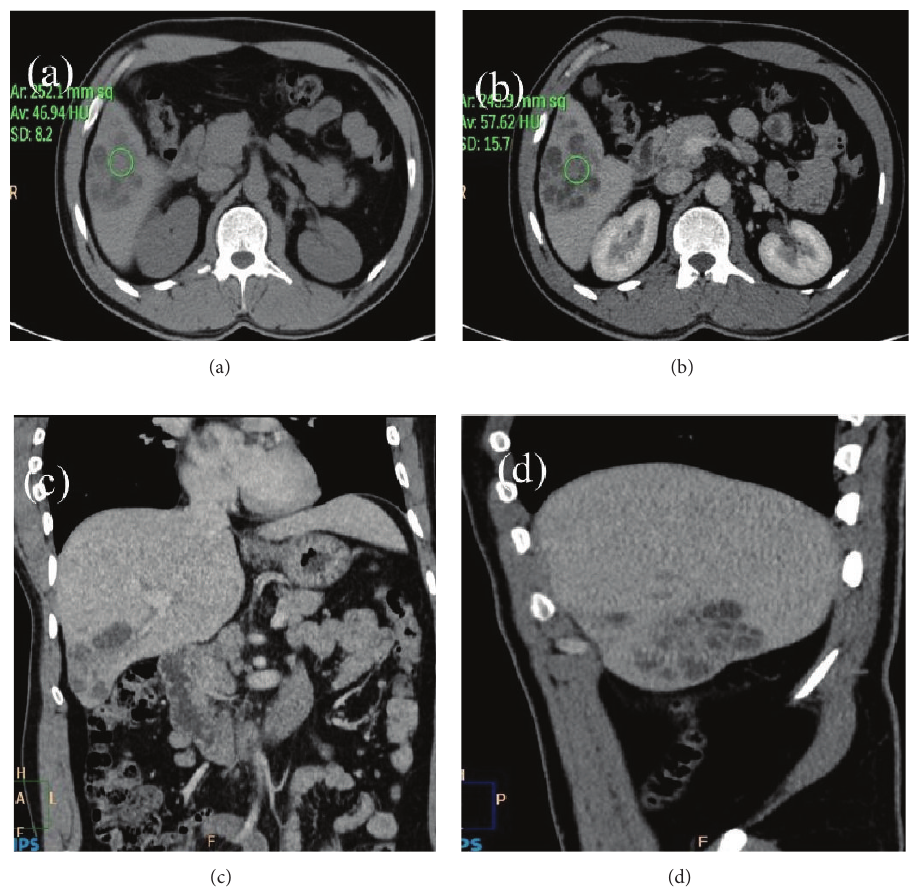
Figure 1: (a) Plain CT image of abdomen: axial view showing ill-defined, mixed density mass lesions in segment V of liver. Hounsfield unit at noncystic part is 47 in the center of the lesion. (b) Postcontrast CT image of abdomen: axial view showing ill-defined heterogeneously enhancing conglomerated mass lesions in segment V of liver. Hounsfield unit at noncystic part is 57 in the center of the lesion. (c) Postcontrast CT image of abdomen: coronal view showing ill-defined conglomerate mass lesions in segment V of liver. Remainder of abdomen and visualized part of lungs are devoid of any significant pathology. (d) Postcontrast CT image of abdomen: sagittal view showing ill-defined conglomerated lesions in segment V of liver. There is mild enlargement of the liver.